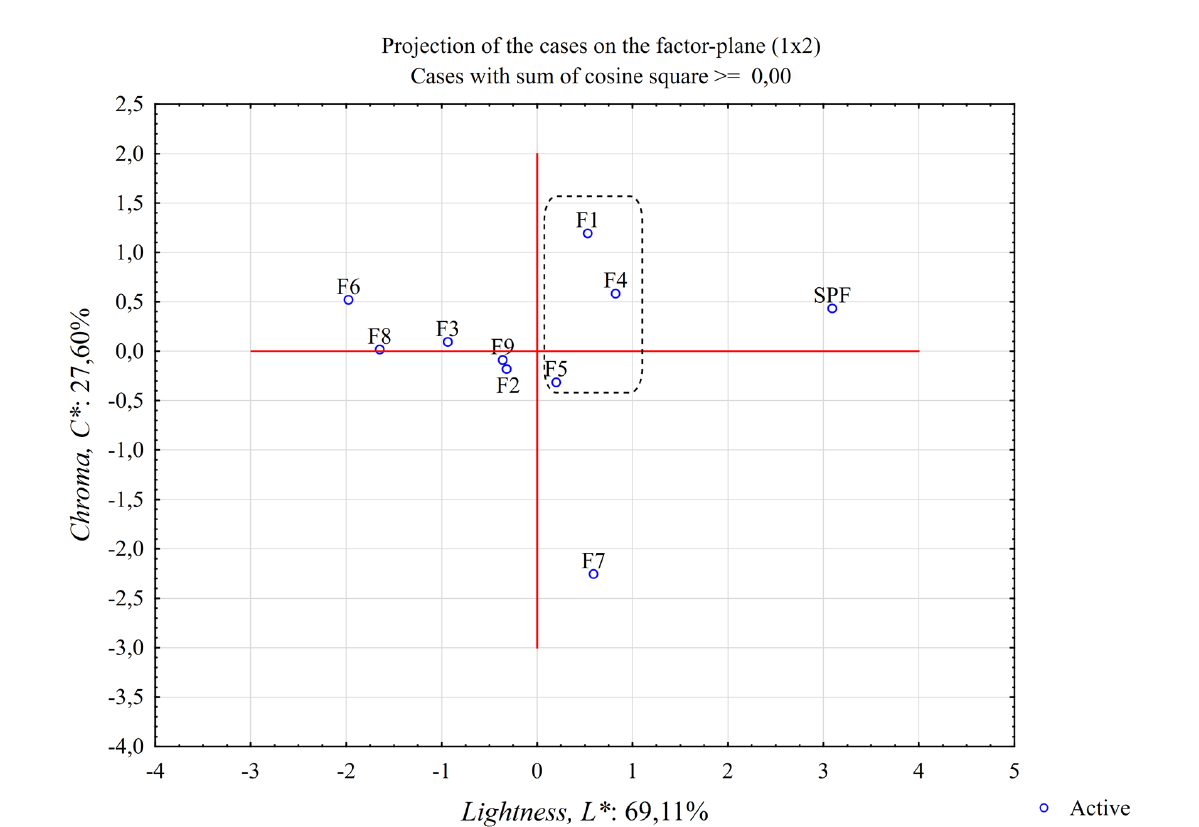
FIGURE 4 – Two-dimensional (2D) principal component analysis (PCA) score plot based on CIE L * C * h color